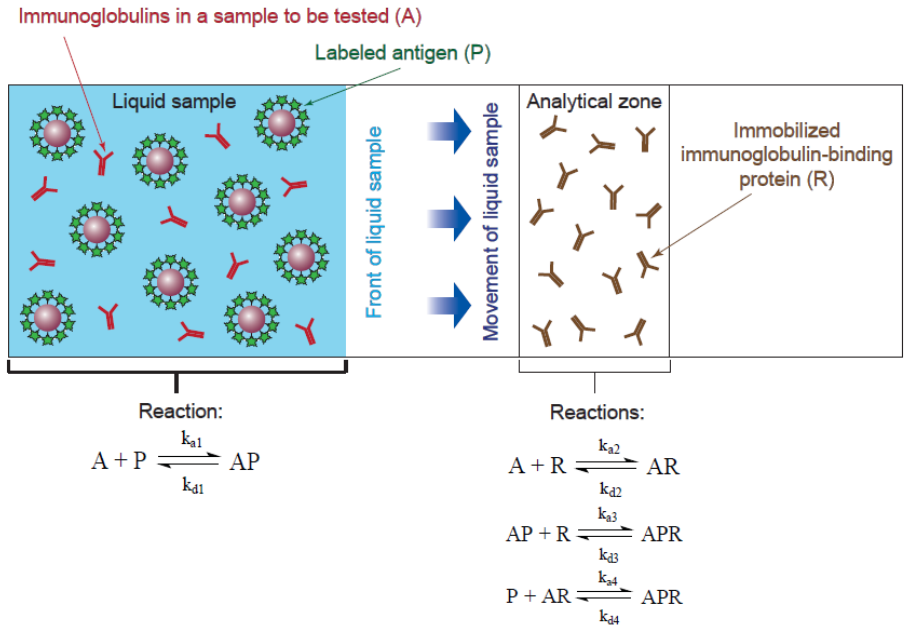
Figure 2. Simplified diagram of the ICA system for serodiagnostics according to the B scheme used to construct the model.